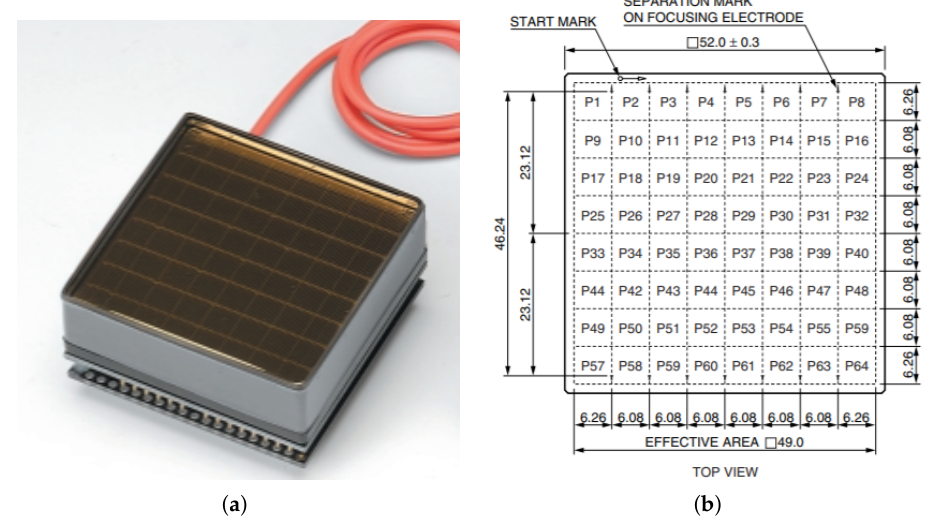
Figure 1. Multi anode PMT Hamamatsu with its schematic top view [20]. ( a ) Multi anode PMT Hamamatsu H10966A-100. ( b ) Anode matrix